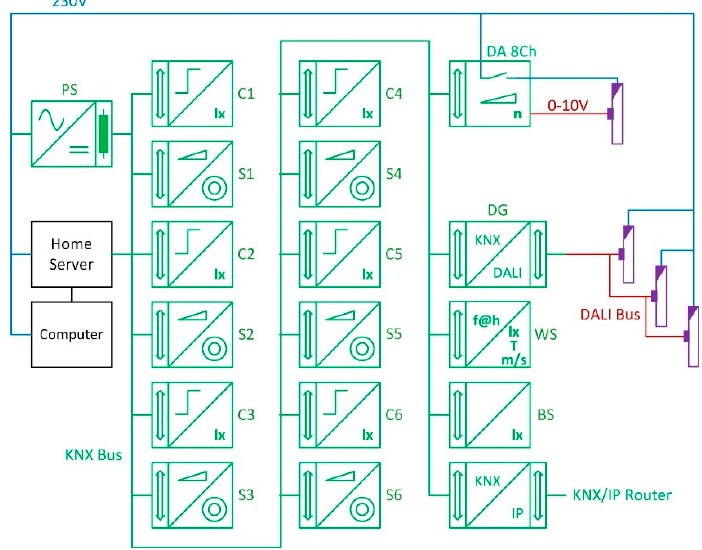
Figure 2. A structure of the KNX lighting control system in the SKNX & EIEE Laboratory (the symbols of devices are standardized by the KNX Association).